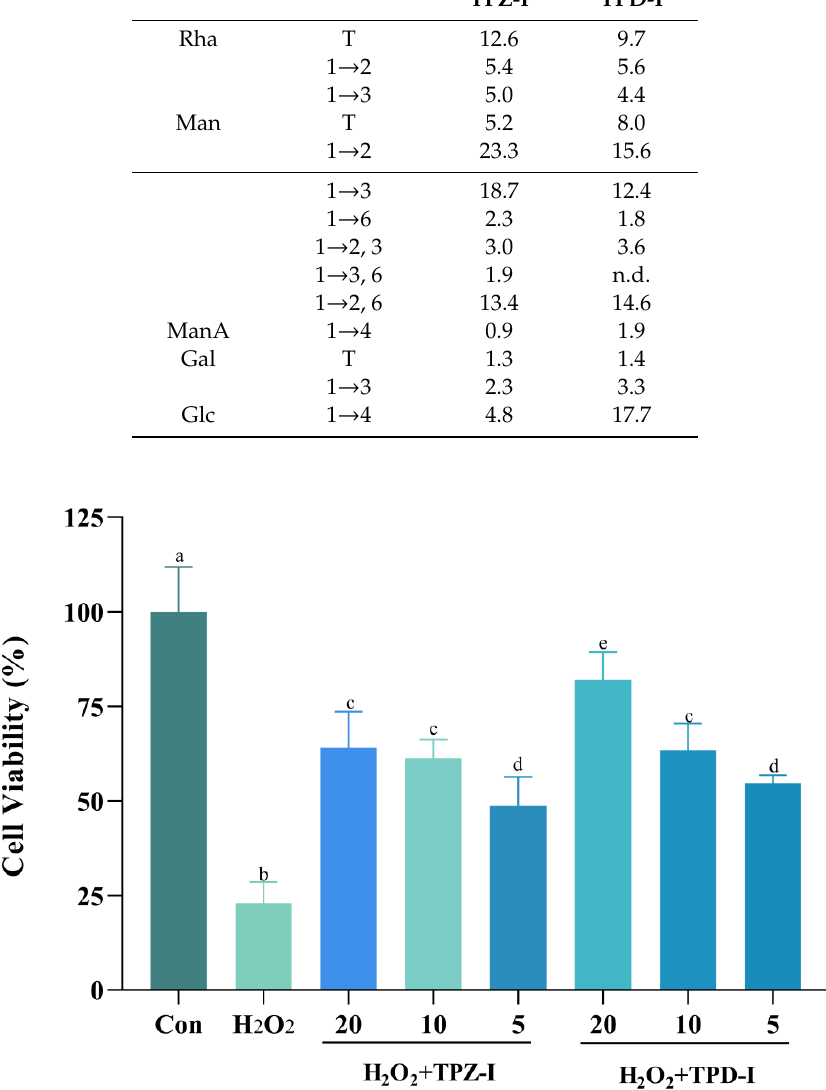
Figure 3. Protective effects of TPZ-I and TPD-I on viability loss in porcine jejunum epithelial cells (IPEC-J2) induced by H 2 O 2 (0.2 mM). The concentrations of polysaccharide fractions were 20, 10, and 5 μg/mL, respectively. Values are presented as means ± Standard error. Bars with different letters are statistically significant ( p < 0.05).